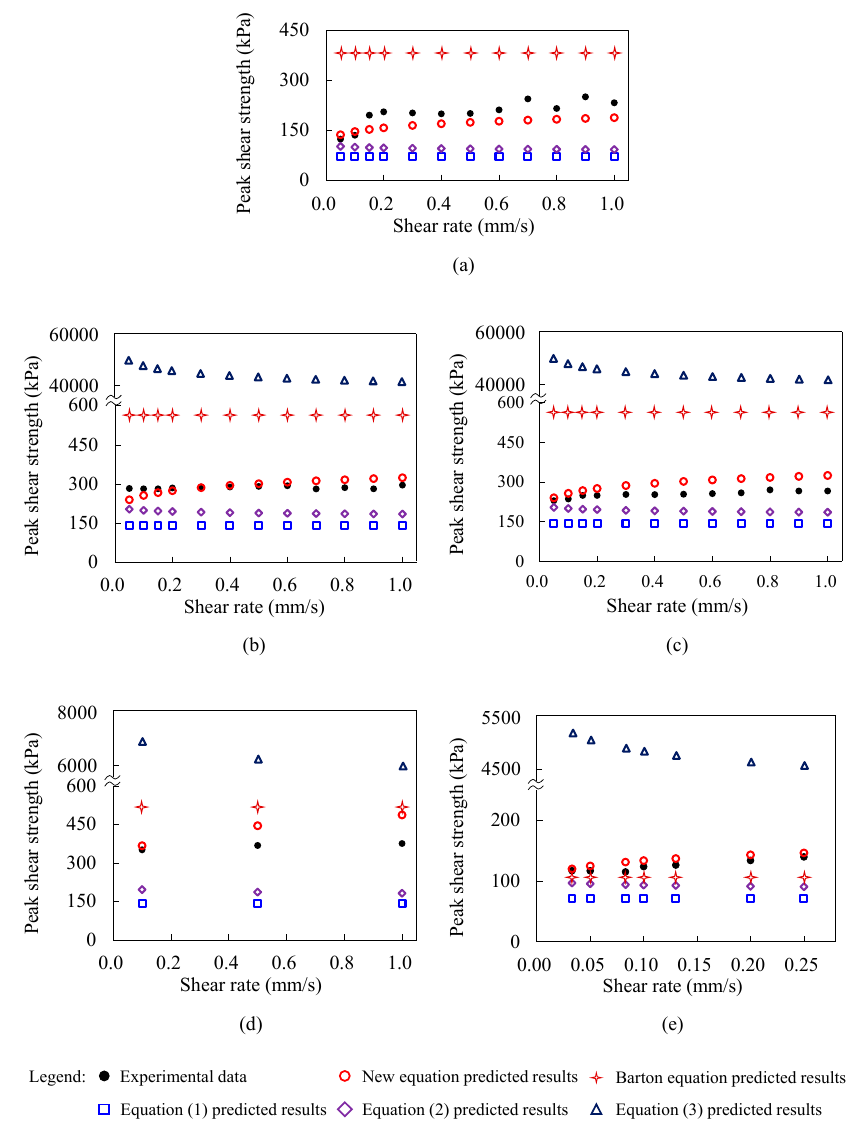
Figure 7. Comparison on the peak shear strength between the experimental data and the predicted results for granite discontinuity samples ( a ) Case of sample 1#; ( b ) Case of sample 2#; ( c ) Case of sample 3#; ( d ) Case of sample 4#; ( e ) Case of sample 5#. Note that in case of sample 1#, the predicted results calculated via Equation (3c) are negative which were not drawn.